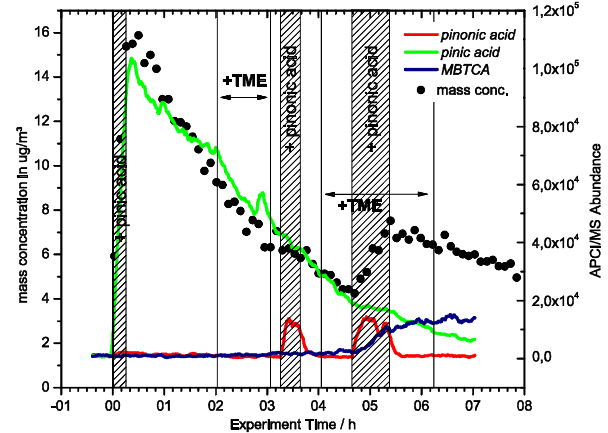
Fig. 2. APCI(-) mass traces of pinic acid ( m/z 185 green), pinonic acid ( m/z 183 red), MBTCA ( m/z 203 blue), particle mass concentration measured by SMPS (filled dots); The hatched area marks the addition of pinic acid and pinonic acid, the borders marked with arrows (+TME) is the time of OH-production.